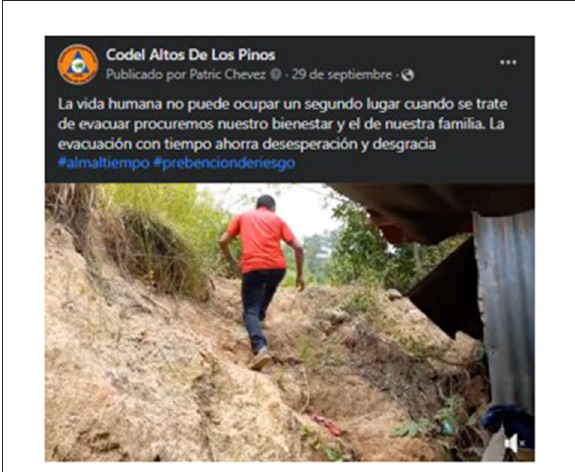
FIGURE4 Risk communication in the Altos de los Pinos neighborhood. Translation: “Human life cannot take second place when it comes to evacuating. Let’s seek our wellbeing and that of our family. Timely evacuation saves despair and misfortune.”